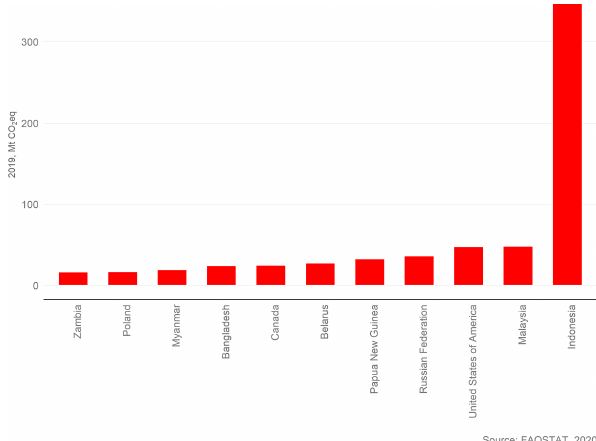
Figure 7. Top 10 countries by emissions from drained organic soils (75% of global